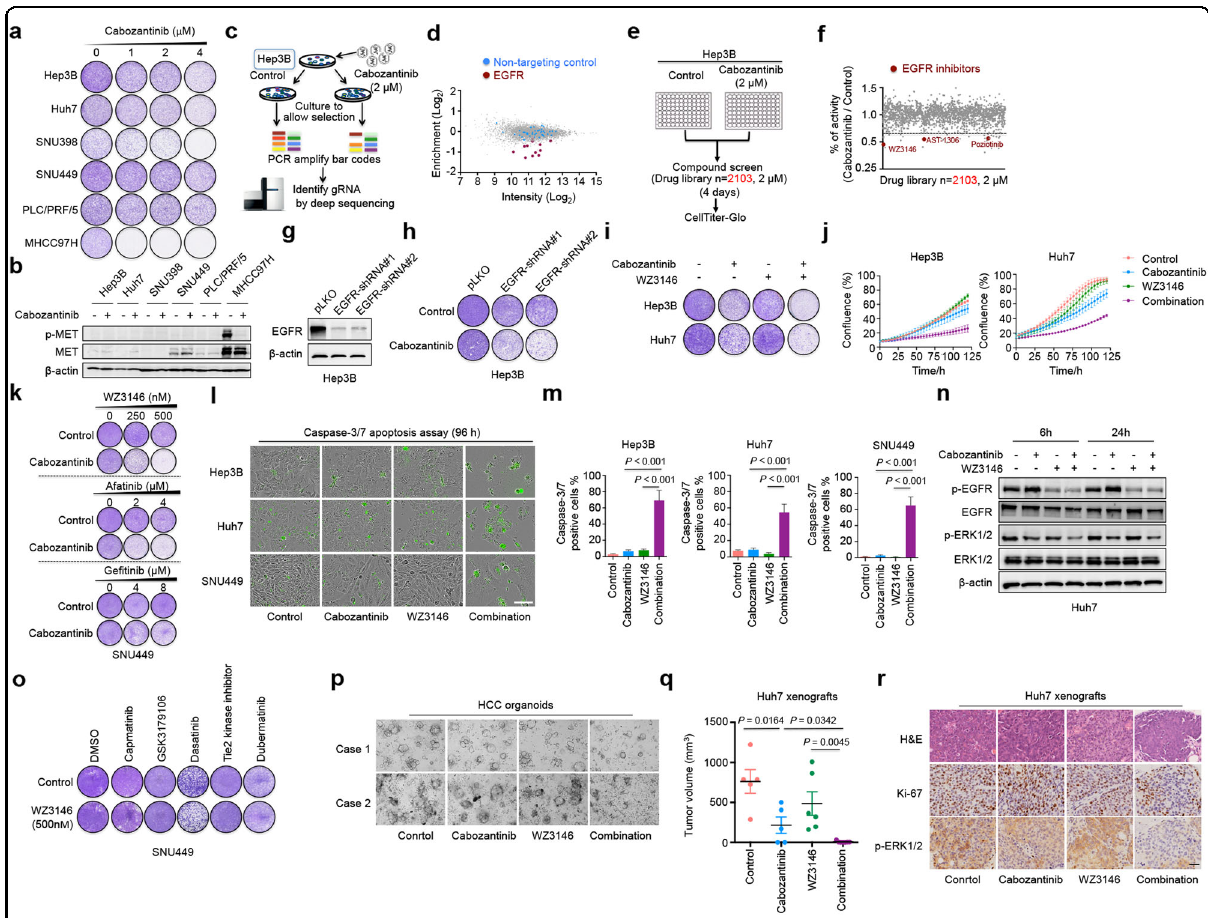
representation of the CRISPR-Cas9-based kinome screens performed in Hep3B cells. d EGFR was identi fi ed as a high-con fi dence synthetic lethal gene with cabozantinib in Hep3B cells. e Schematic outline of the compound screen ( n = 2103). Hep3B cells were screened with compound library in the presence or absence of 2 μ M cabozantinib for 4 days. Cell viability was measured using CellTiter-Glo assay. f Graph depicting the effects of compounds on cell viability. g Hep3B cells were stably transduced with control pLKO vector or with two independent shRNAs targeting EGFR (shEGFR#1, shEGFR#2) and the ef fi ciency of knockdown was evaluated by western blot. h Colony formation assays of Hep3B cells with and without EGFR knockdown were performed in the absence or presence of cabozantinib (4 μ M). i , j Long-term colony formation assays and IncuCyte cell proliferation assays showing synergistic response to cabozantinib (4 μ M) combined with WZ3146 (500 nM) in Hep3B and Huh7 cells. k Long-term colony formation assays testing the synergistic effect of cabozantinib (4 μ M) and FDA-approved EGFR inhibitors (ge fi tinib and afatinib) on SNU449 cells. l , m Representative images of Hep3B, Huh7 and SNU449 cells treated with cabozantinib (4 μ M), WZ3146 (500 nM) or the combination of both drugs for 96 h in the presence of a green fl uorescent caspase-3/7 activatable dye (scale bar = 100 μ m). The proportion of cells containing caspase-3/ 7 staining is shown. n Huh7 cells were treated with cabozantinib (4 μ M), WZ3146 (500nM) or the combination of both drugs at the indicated time points prior to western blot analysis with the indicated antibodies. o Long-term colony formation assays testing the synergistic effect of WZ3146 (500nM) and c-MET inhibitor (capmatinib, 4 μ M), c-RET inhibitor (GSK3179106, 4 μ M), c-KIT inhibitor (dasatinib, 50 nM), TIE2 inhibitor (Tie 2 kinase inhibitor, 4 μ M), or AXL inhibitor (dubermatinib, 25 nM), respectively. p Representative images of HCC organoids treated with cabozantinib (2 μ M),